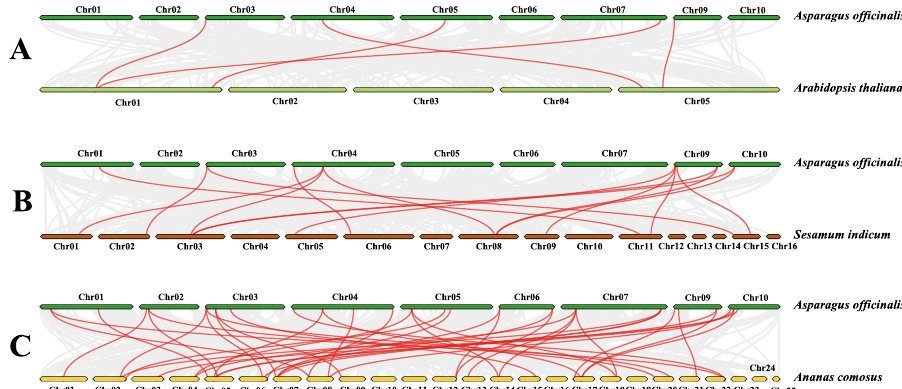
Figure 6. Schematic diagram of syntenic analysis. Synteny of the AoNAC genes with the NAC genes of A. thaliana ( A ), S. indicum ( B ), and A. comosus ( C ) was visualized by MCScanX and TBtools software. The gray lines between the chromosomes of the two species indicate all synteny blocks, and the red lines represent the synteny of their NAC genes.